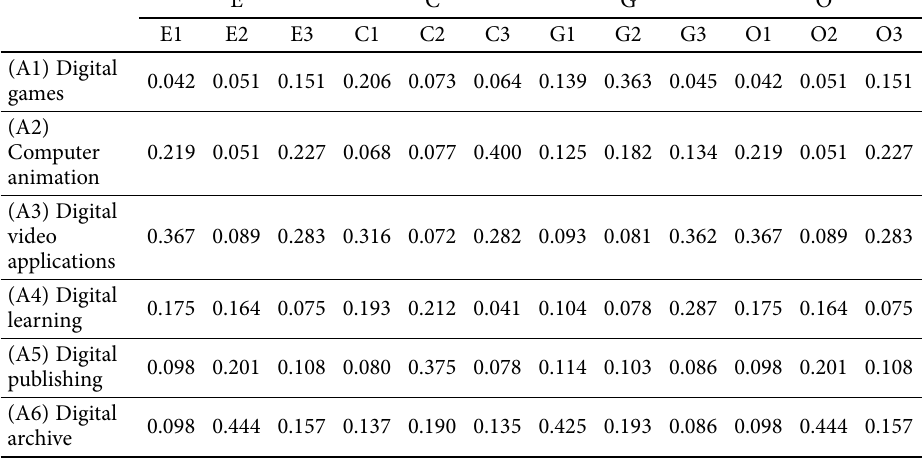
Table 7. The ideal solution and negative solution E C G O E1 E2 E3 C1 C2 C3 G1 G2 G3 O1 O2 O3